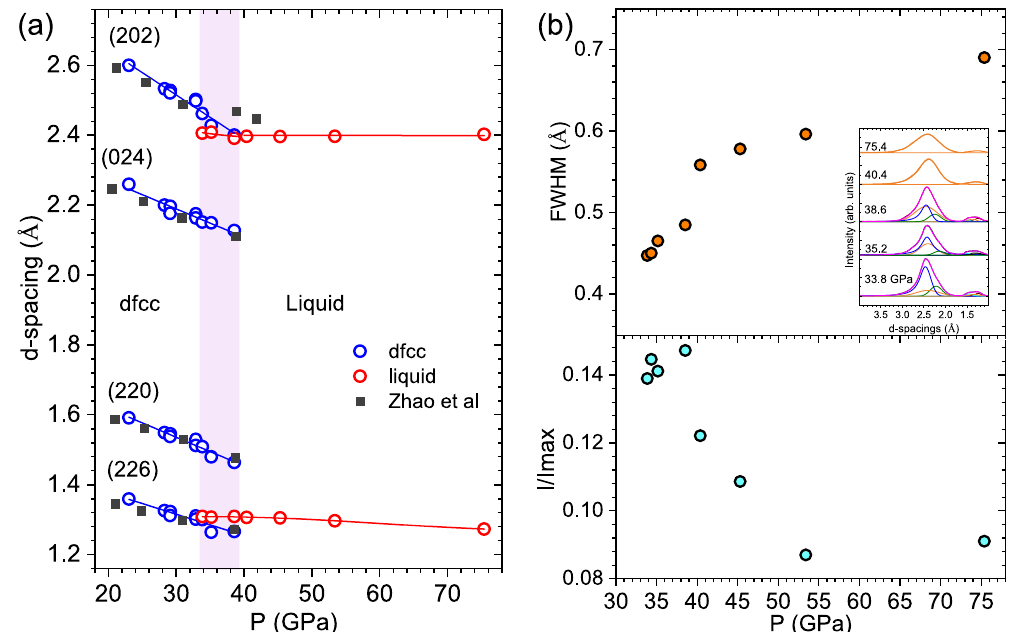
Figure 4. ( a ) d-spacings of four strongest reflections of high pressure phases as a function of pressure. Blue circles correspond to the dfcc solid phase, whereas the red circles correspond to the liquid phase. Solid squares are from Zhao et al. 17 DAC studies. The pink shaded section is where dfcc+liquid phase co-exist with each other. Blue and red solid lines are fits to the data. ( b ) The bottom graph shows the relative intensity ratio of the broad peak at 1.35 Å (I), with respect to the strong broad peak at 2.4 Å ( I max ). The top graph shows the measured FWHM of the intense peak contributing from the liquid phase (orange peaks in the inset) at 2.4 Å. The deconvolution of peaks showing the contribution from solid and liquid phase is presented in the Figure 3b plots the lattice parameters determined using the x-ray diffraction data. We observe a decrease in the lattice parameters with increasing pressure, which suggests the stiffening of the lattice. The c -axis seems